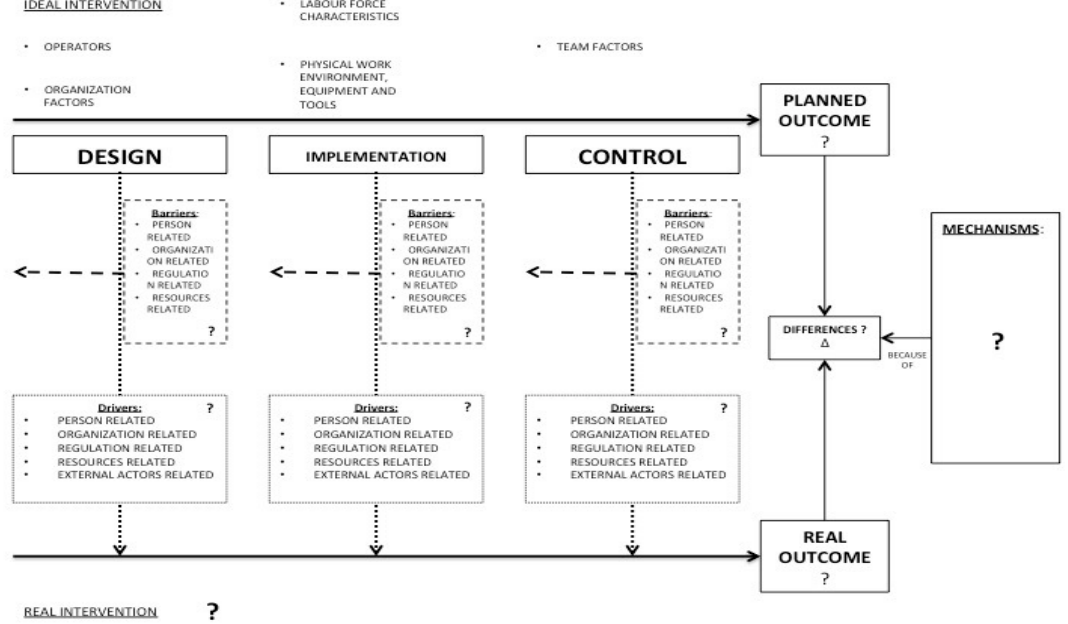
Figure 2. The analytical research framework (“?” is the object of the investigation; “ Δ ” is the difference between the planned outcome and the real outcome).